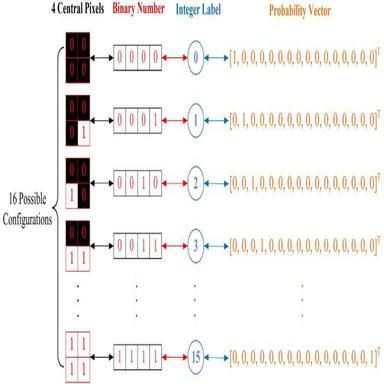
Flow chart of data conversion (taking 4-central-pixel data template as the example).